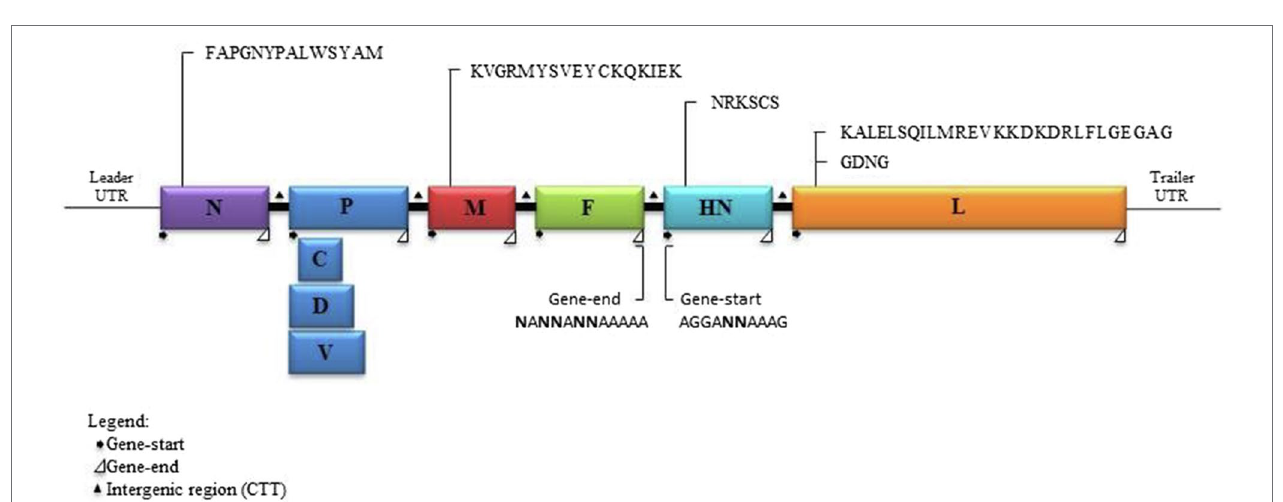
FIGURE 4 | Schematic diagram of a DcPIV3 genome with the transcriptional gene-start, intergenic, and gene-end sequences. The gene sizes are shown as boxes that are drawn to approximate scale. The positions of the extragenic 3 ' leader, 5 ' terminal trailer, and gene junctions are shown as horizontal lines. The conserved gene-start and gene-end transcription regulatory sequences at the boundaries between genes are